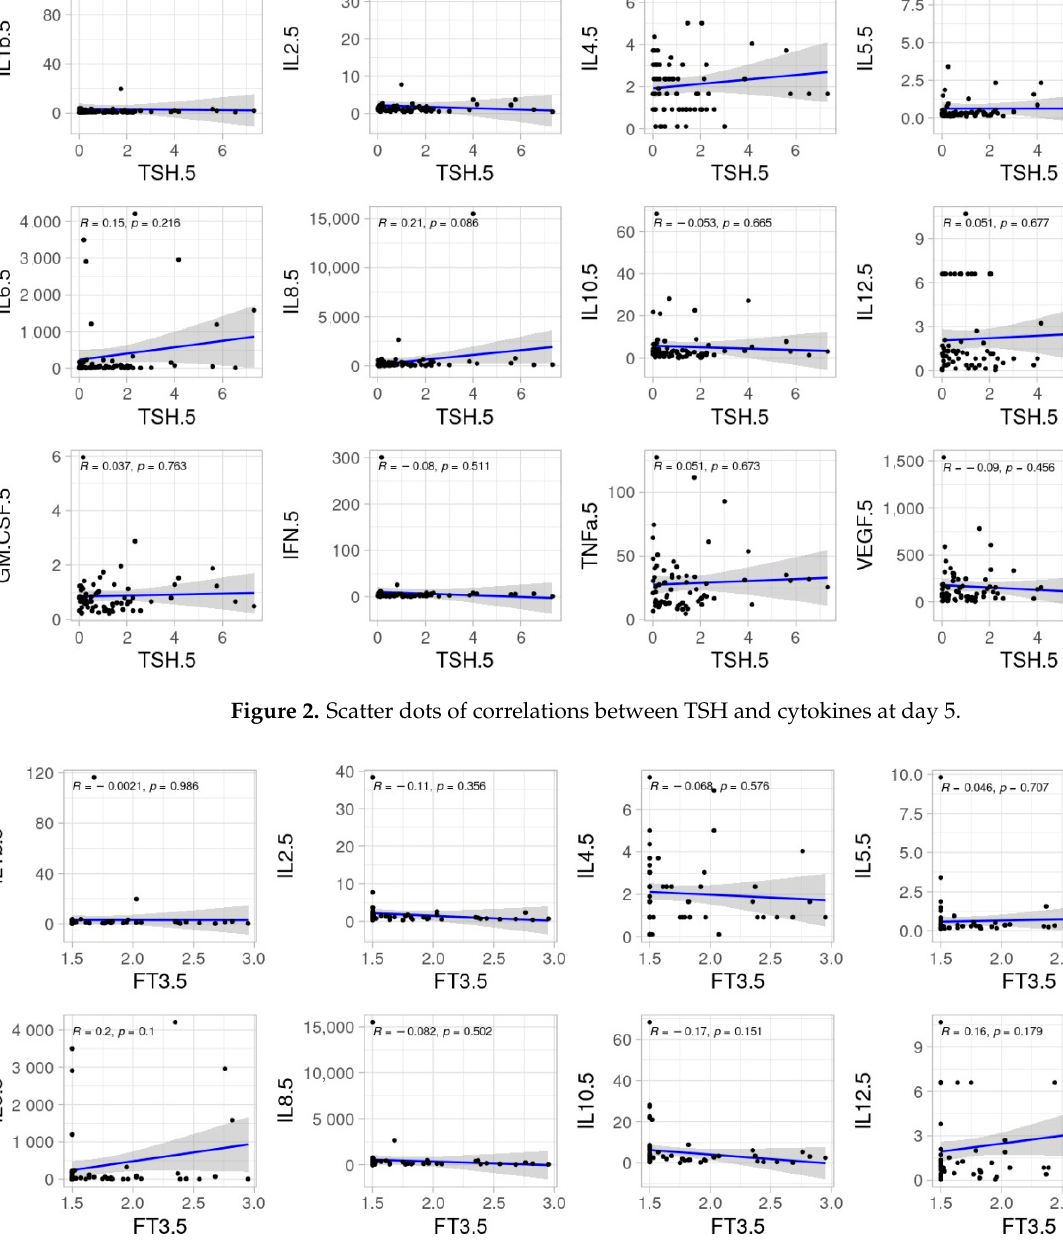
B Figure 1. Heat map showing the associations of the thyroid hormones and cytokines evaluated at ICU admission ( A ) and day 5 ( B ). Pearson correlation coefficients are displayed. Circles representing